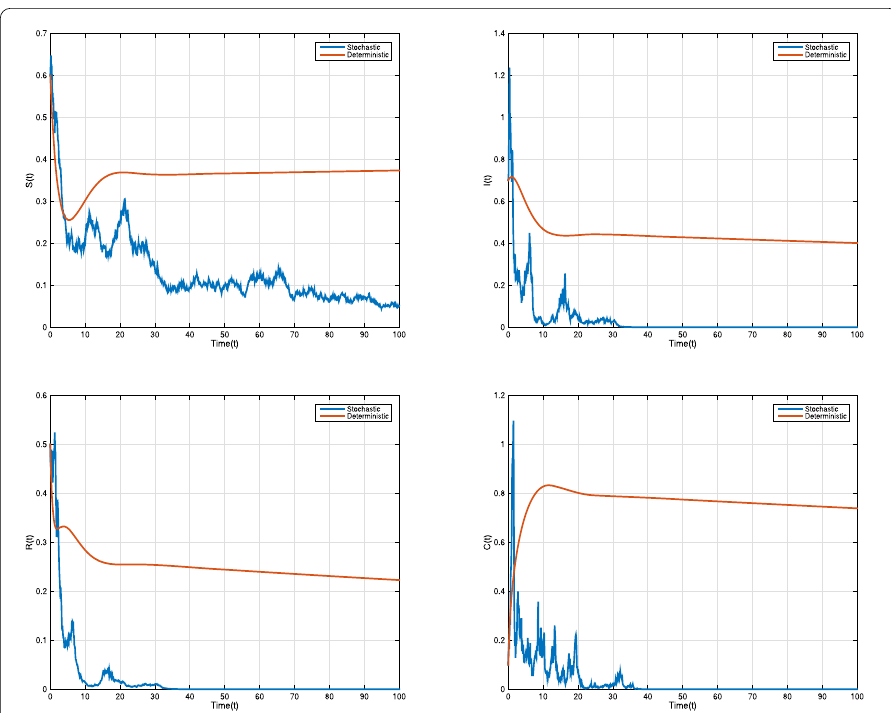
Figure 7 Time response of solutions for model (2) (right) and corresponding deterministic model (1) (left), when R 0 = 1.78 > 1, the infection persists in the deterministic model; when R s 0 = 0.75 < 1, the infection dies out in the stochastic model. With parameter values η = 0.02, ξ = 0.5, β = 0.1, σ = 0.2, α = 0.26, γ = 1 and white noises ν 1 = 0.13, ν 2 = 0.54, ν 3 = 0.26, ν 4 =